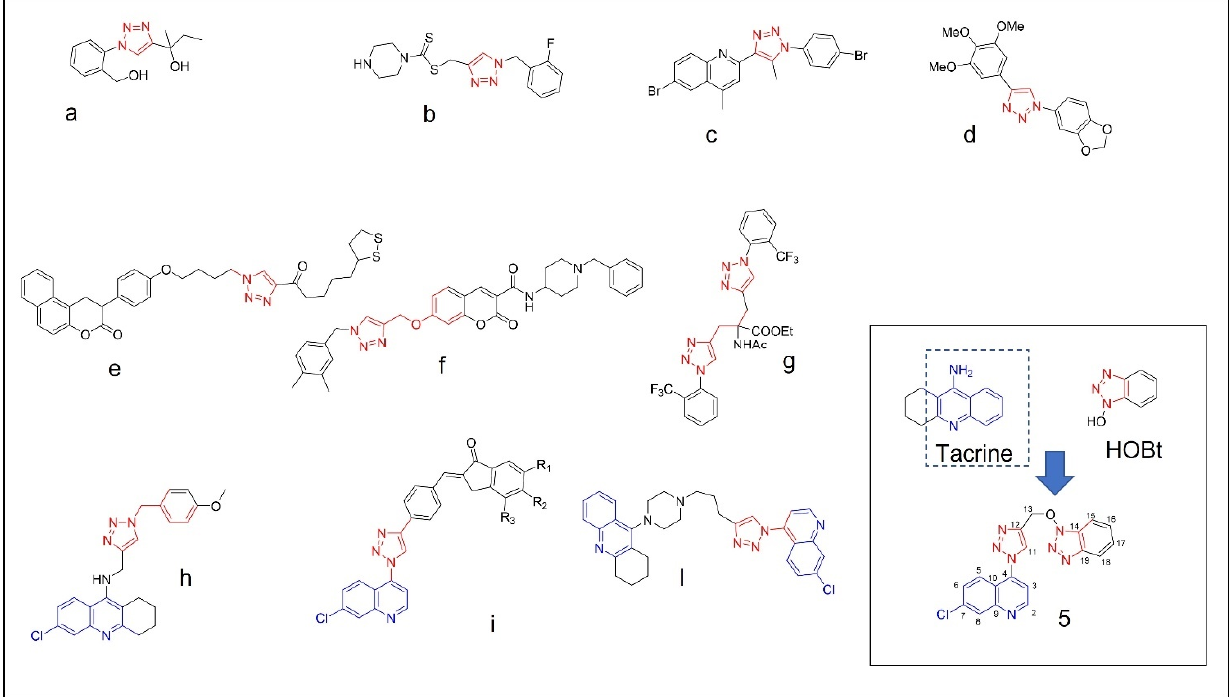
Figure 1. Example of 1,2,3-triazole (red) containing bioactive molecules reported in literature ( a – d ) [13–16], 1,2,3-triazole ( e – g ) [18–20] and 1,2,3 triazole containing quinoline ring (blue) active against cholinesterases ( h – l ) [21–23]; the structure of compound ( 5 ), structurally related to tacrine and HOBt, is reported in the inset of the